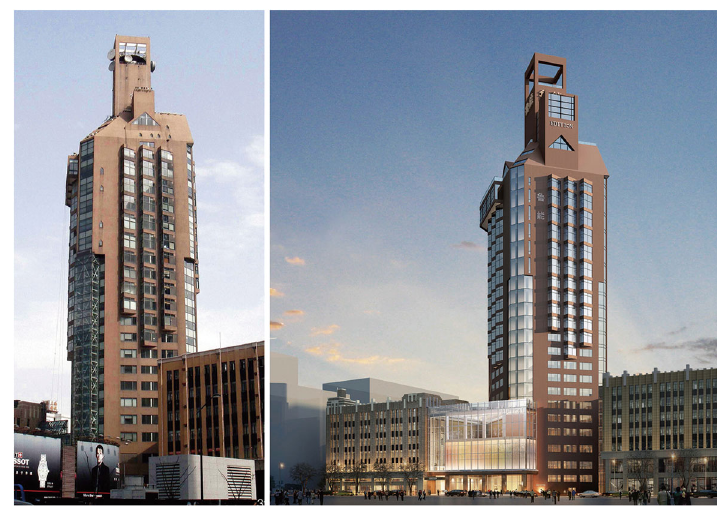
Fig. 9 Condition of the SECEP Building before renovation and an artist ’ s rendering of the chosen renovation scheme initiated in 2013 (Source: Images provided by